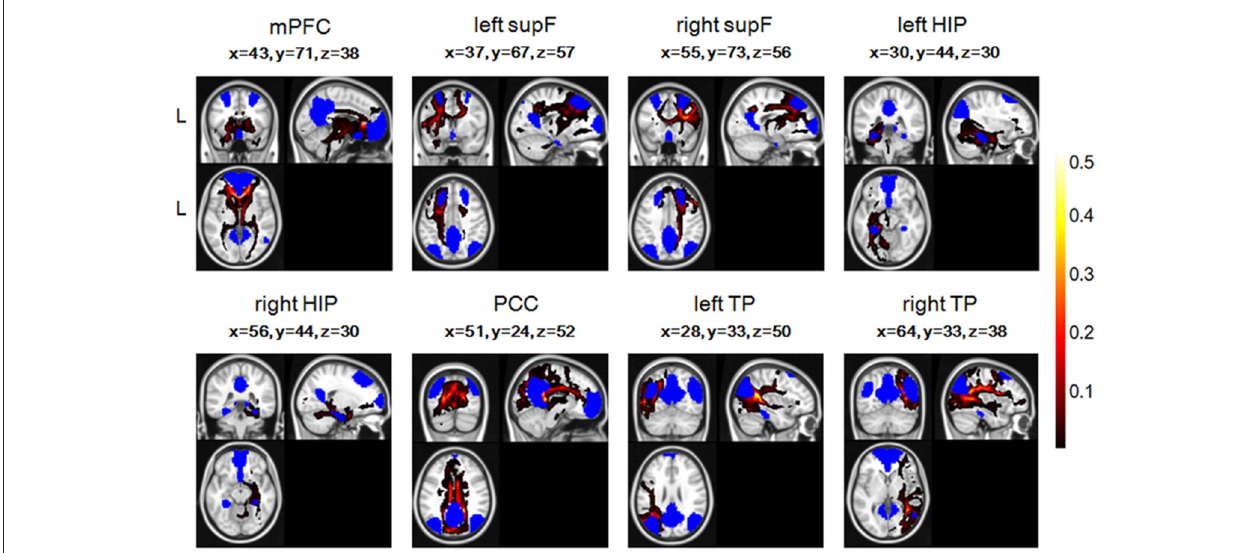
FIGURE 2 | The fiber tracts of the probabilistic tractography of eight regions in the DMN and their coordinates in one single subject, with blue representing the eight seed regions. The color of each voxel represented the number of fibers passing through this voxel divided by the total number of fibers sampled from the eight seed